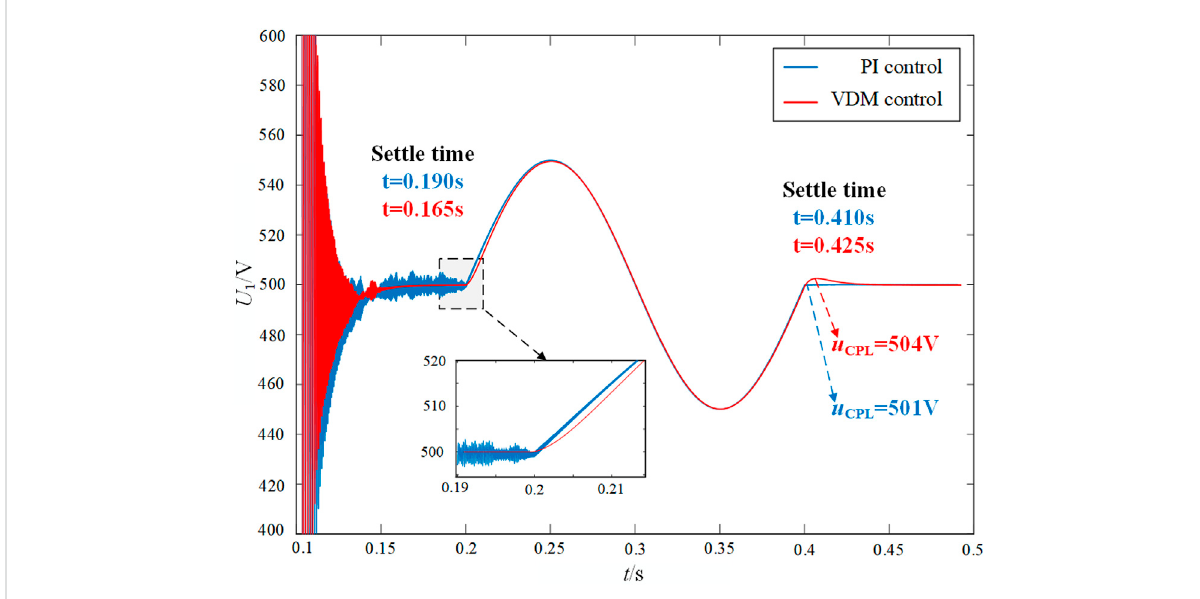
FIGURE 14 Comparison diagram of CPL voltage under CPL load fault condition.